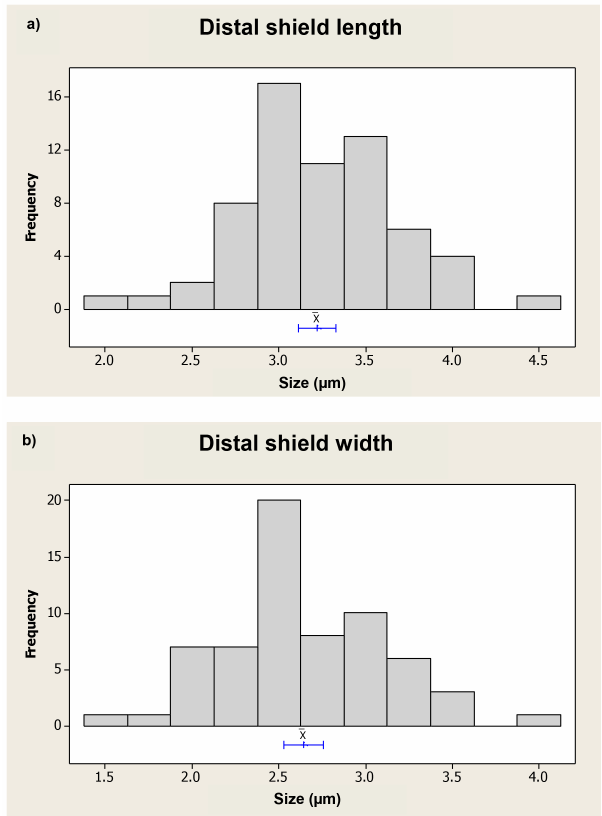
Figure 4. Frequency distribution histograms of all the measure- ments taken for distal shield length (a) and width (b) : 95% t confi- dence for mean is